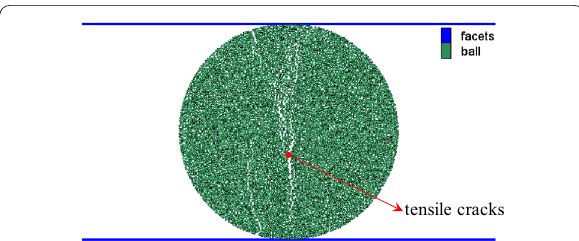
Fig. 13 Failure state when the water–cement rate was 0.35.